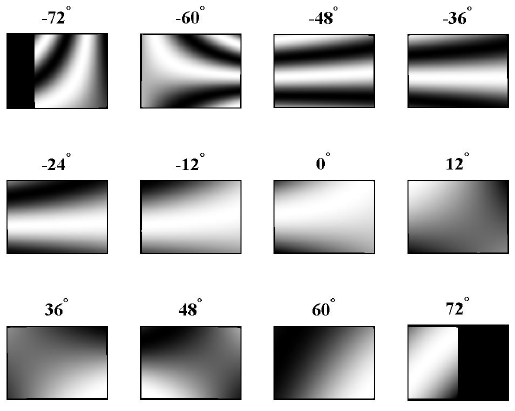
Figure 9. The interferogram of translation error Err k i .